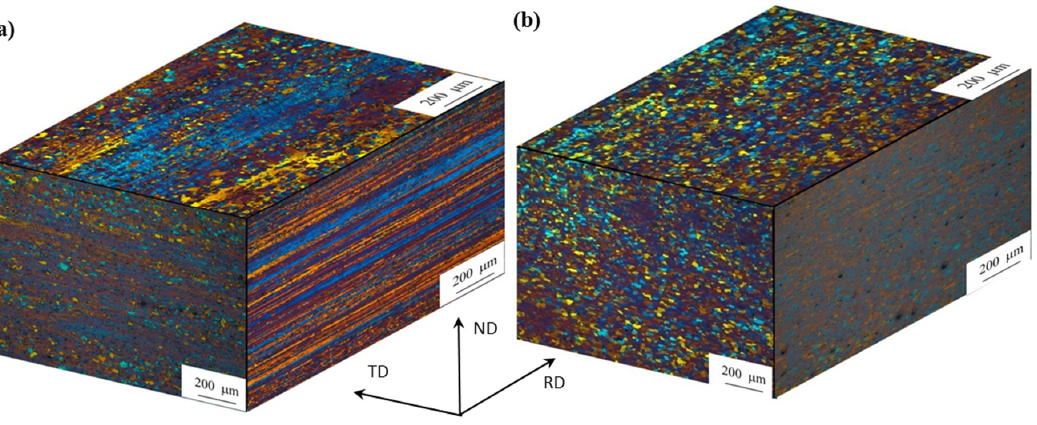
Figure 12. Three direction optical micrographs of ( a ) Ce-containing and ( b ) Ce-free alloys after annealing at 520 ° C for 1 h.